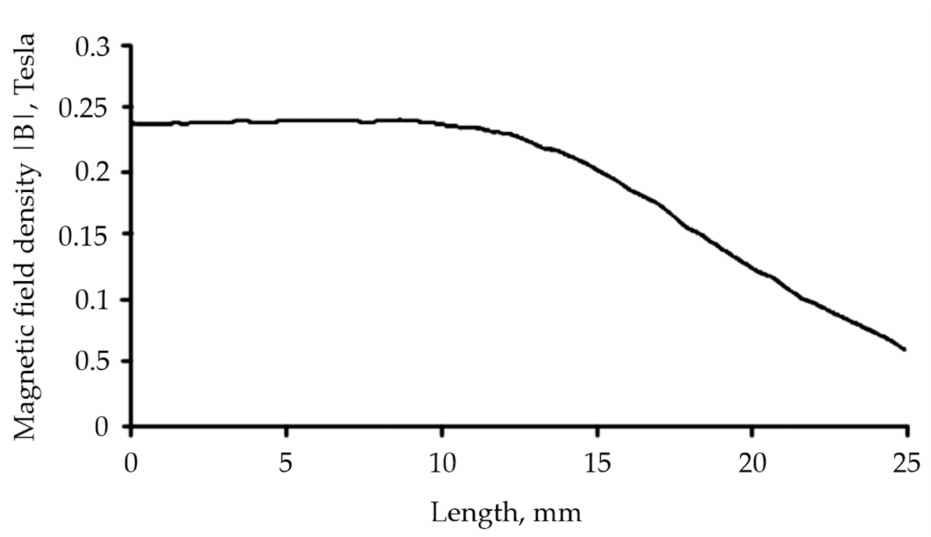
Figure 4. Magnetic flux density across MRE in the